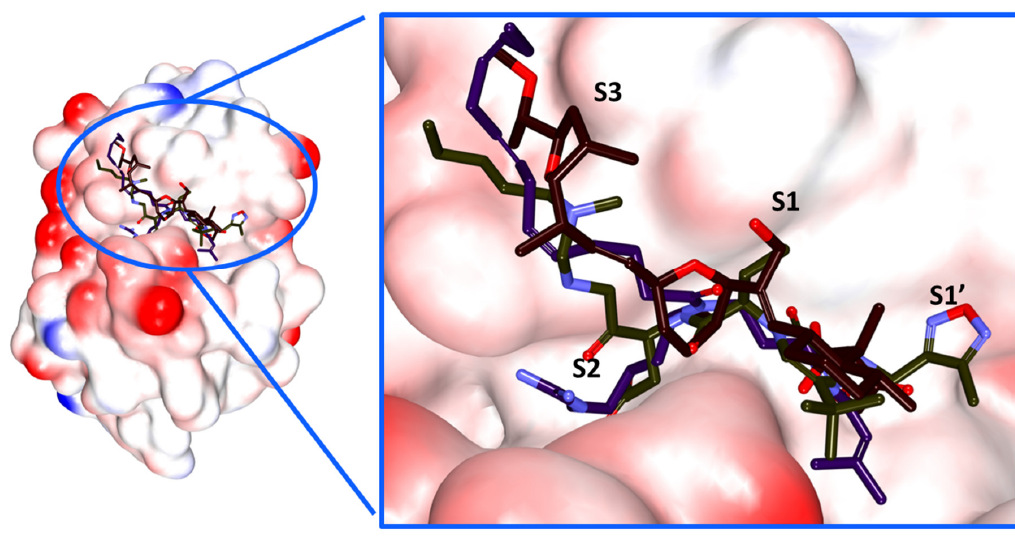
Figure 9. Pictorial illustration of the accommodation of the ligands in the proteins subsites.